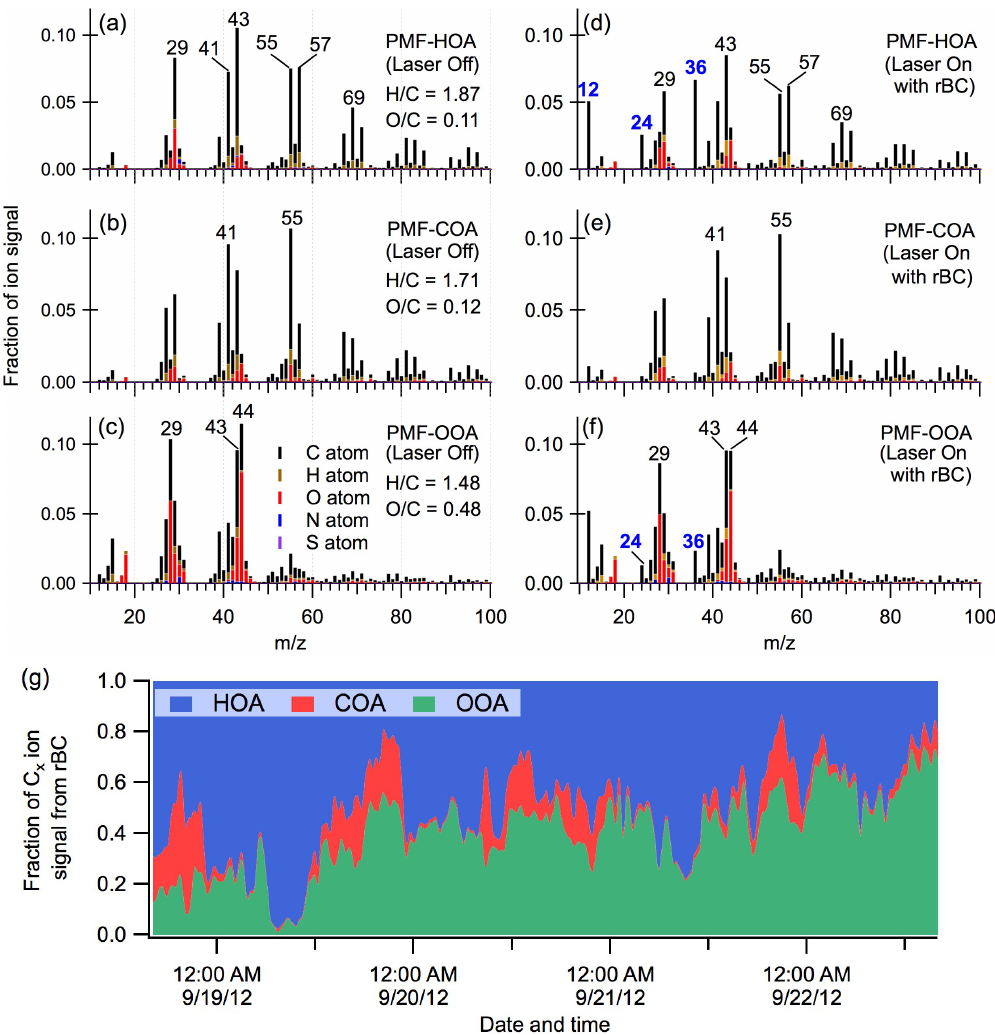
Figure 3. Normalized mass spectra of PMF factors from laser-off (a–c) and laser-on with rBC signals (d–f) mode measurements: ( a , d ) HOA factor, ( b , e ) COA factor, ( c , f ) OOA factor. (g) Mass fraction contribution of total C x signal from each laser-on-mode PMF factor ( d – f